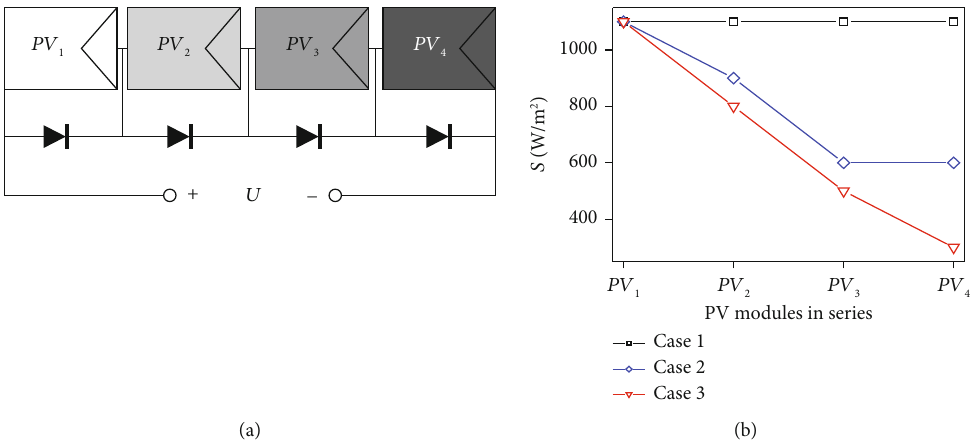
Figure 13: PV system a ff ected by local shading. (a) A schematic diagram of a PV system under local shading. (b) The irradiance of the PV module under three shading